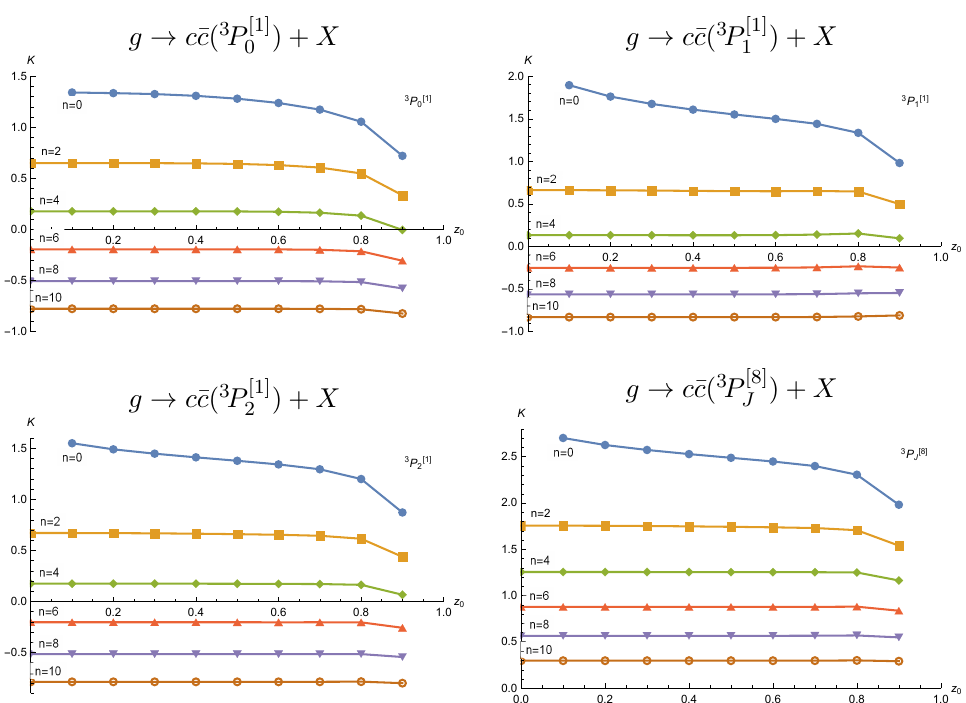
Figure 7 . The K-factors calculated by the integration results with eq. (4.3) for different z 0 and n .